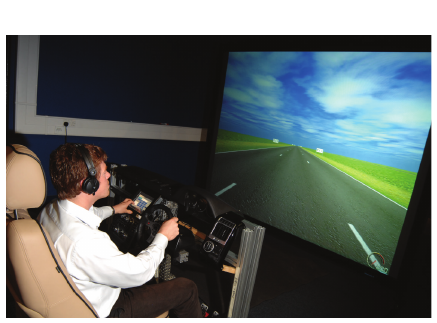
Figure 1: Experiment